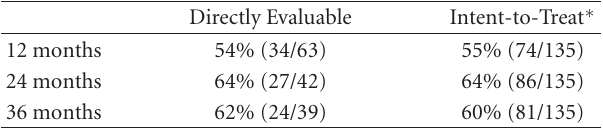
Table 3: 50% Reduction in leaks per day based on diary entries. Directly